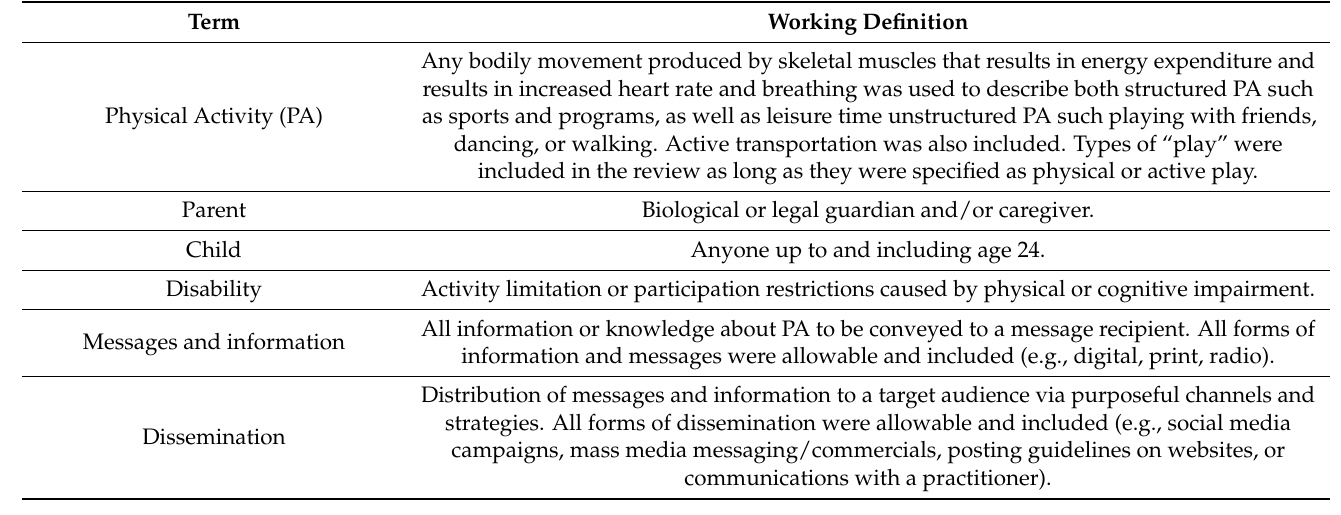
Table 1. Working definitions for the purpose of this